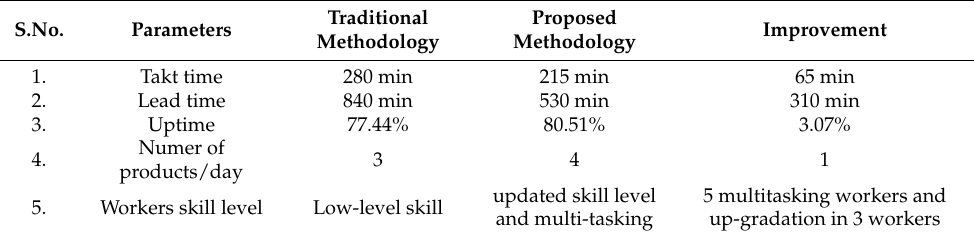
Table 3. Analysis of the improvement achieved by the traditional and proposed methodology. S.No.